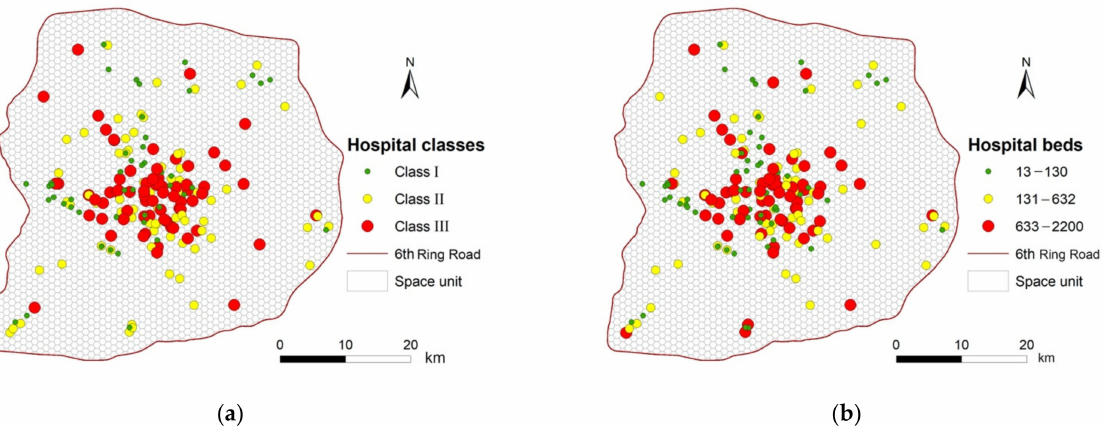
Figure 2. The spatial distribution of the 192 hospitals in the study area colored by ( a ) their class and ( b ) their number of